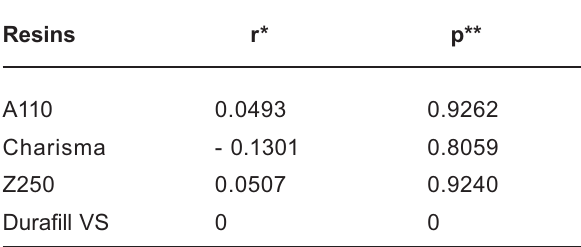
* r = correlation’s index . ** p = significance